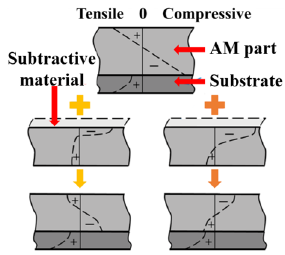
Figure 14 Diagrammatic illustration of residual stress